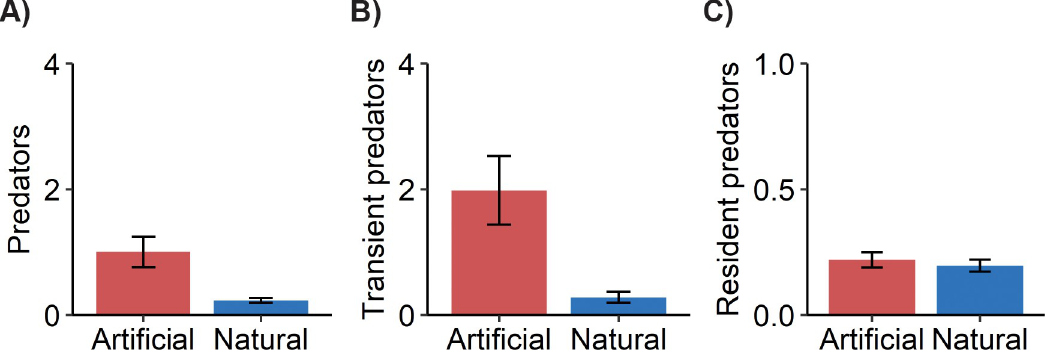
Fig 2. Mean observed density ( ± SE) per transect of predators on artificial reefs (red) versus natural reefs (blue) for A) all predators, B) transient predators, and C) resident predators. These values represent aggregated species-specific densities. N = 109 transects for artificial reefs and 127 transects for natural